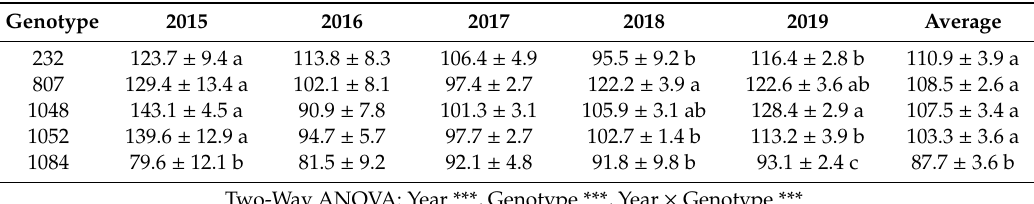
Figure 1. Correlations between WUEi and stomatal conductance (g s ) in the two experimental sites; La Grajera ( A ) and Roda ( B ). Continuous line shows the relation for the La Grajera genotypes and dashed lines shows the same relation for Roda genotypes. Table 3. Variation in WUE i ( µ mol CO 2 mol − 1 H 2 O) per genotype and year in La Grajera field (values are means ±